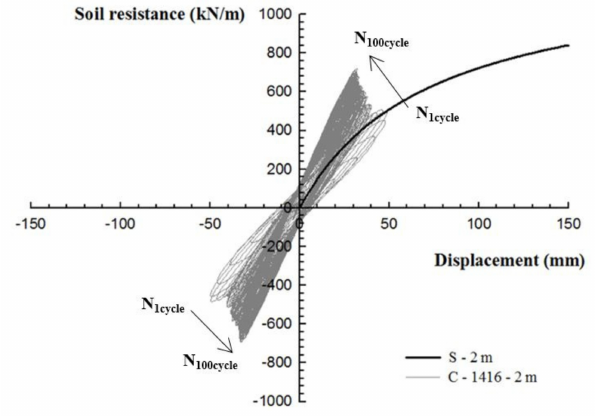
Figure 8. Changes in the experimental cyclic p-y curve due to increase in cycles.